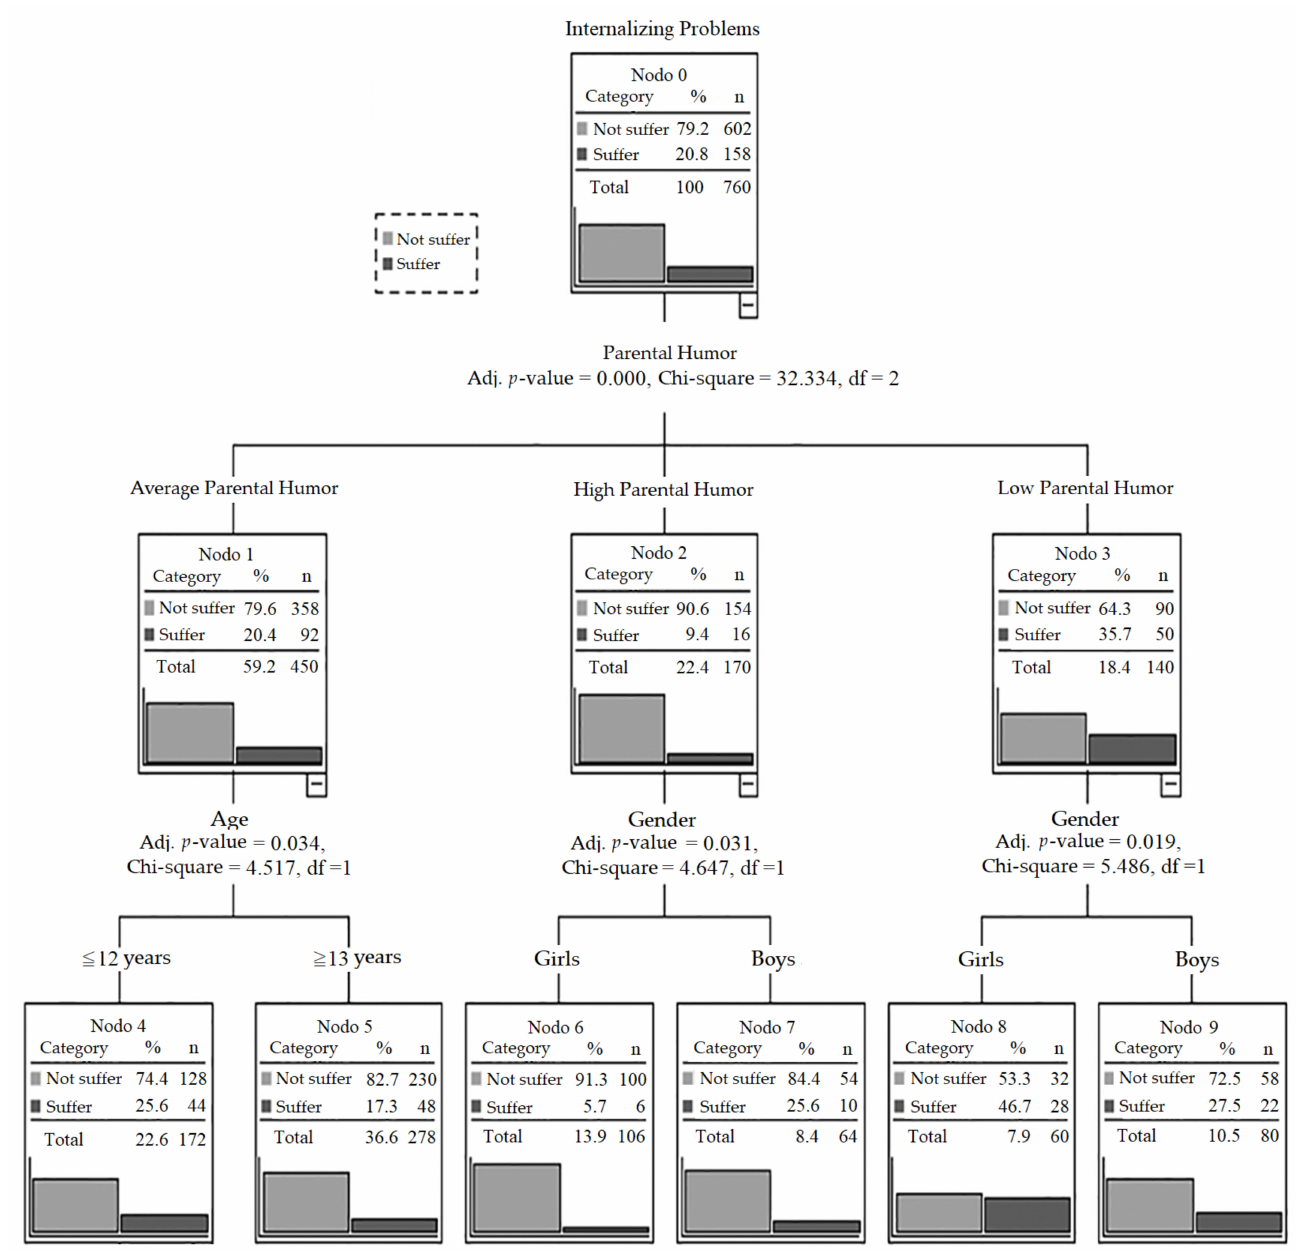
Figure 1. Internalizing Problems Classification